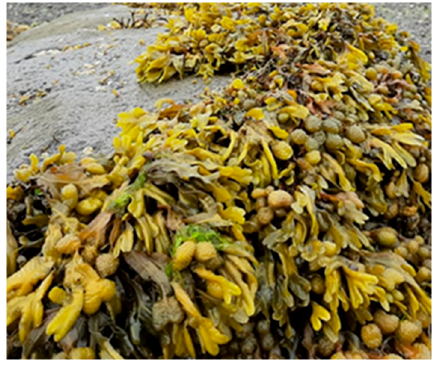
Figure 1. Bladderwrack seaweed.